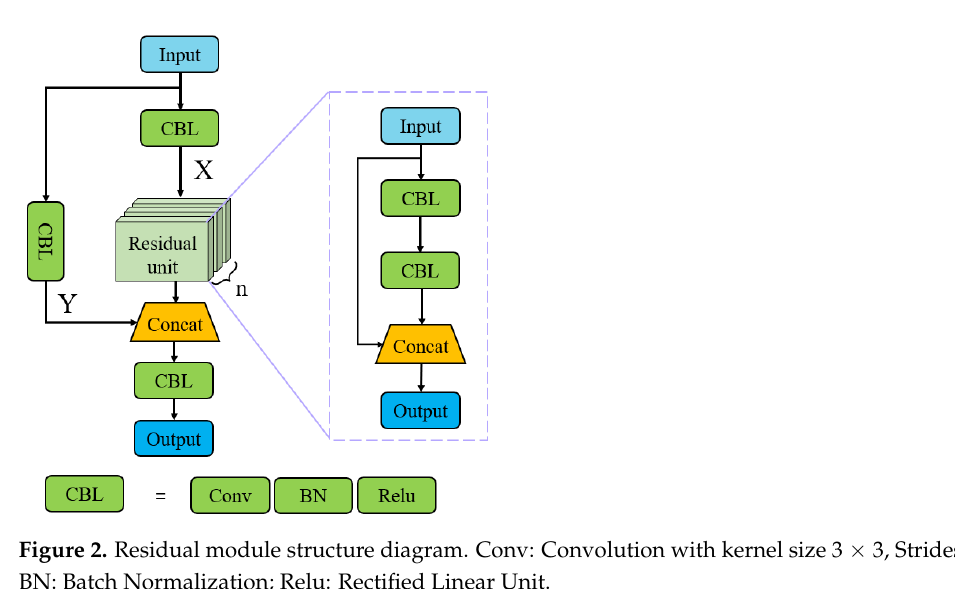
Figure 2. Residual module structure diagram. Conv: Convolution with kernel size 3 × 3, Strides = 2; BN: Batch Normalization; Relu: Rectified Linear Unit.